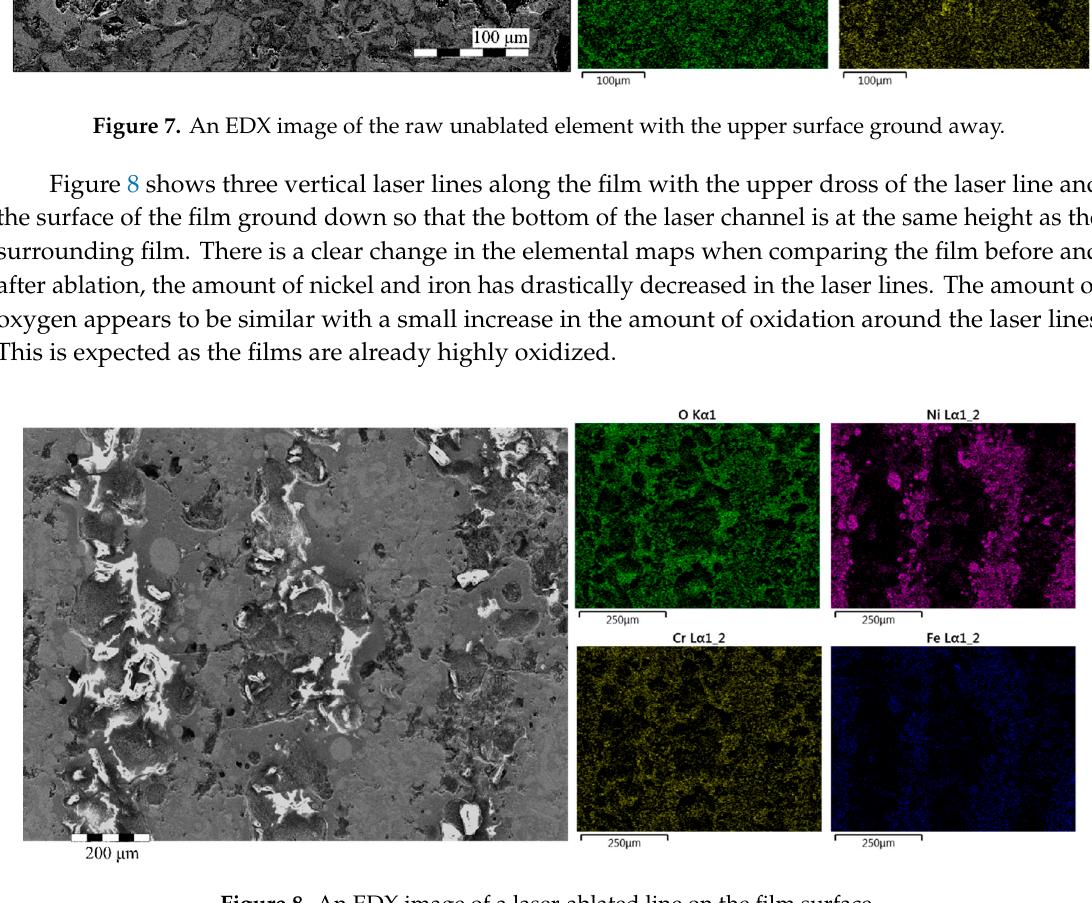
Figure 8. An EDX image of a laser-ablated line on the film surface.